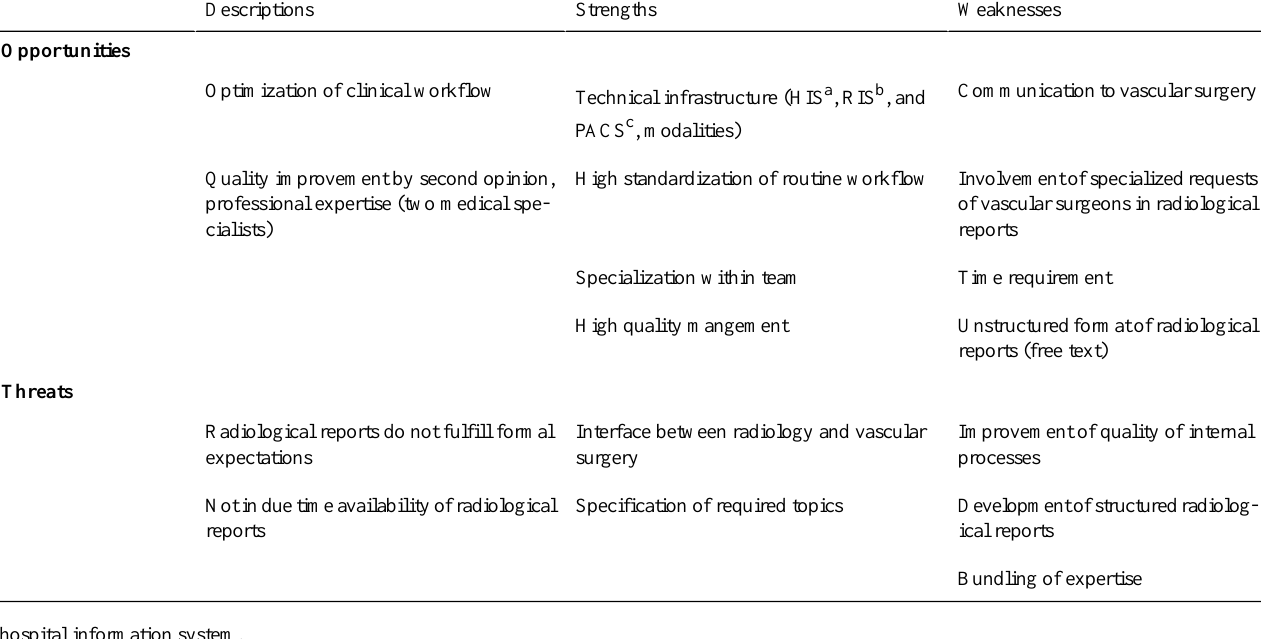
Table 1. SWOT analysis performed between departments of radiology and vascular